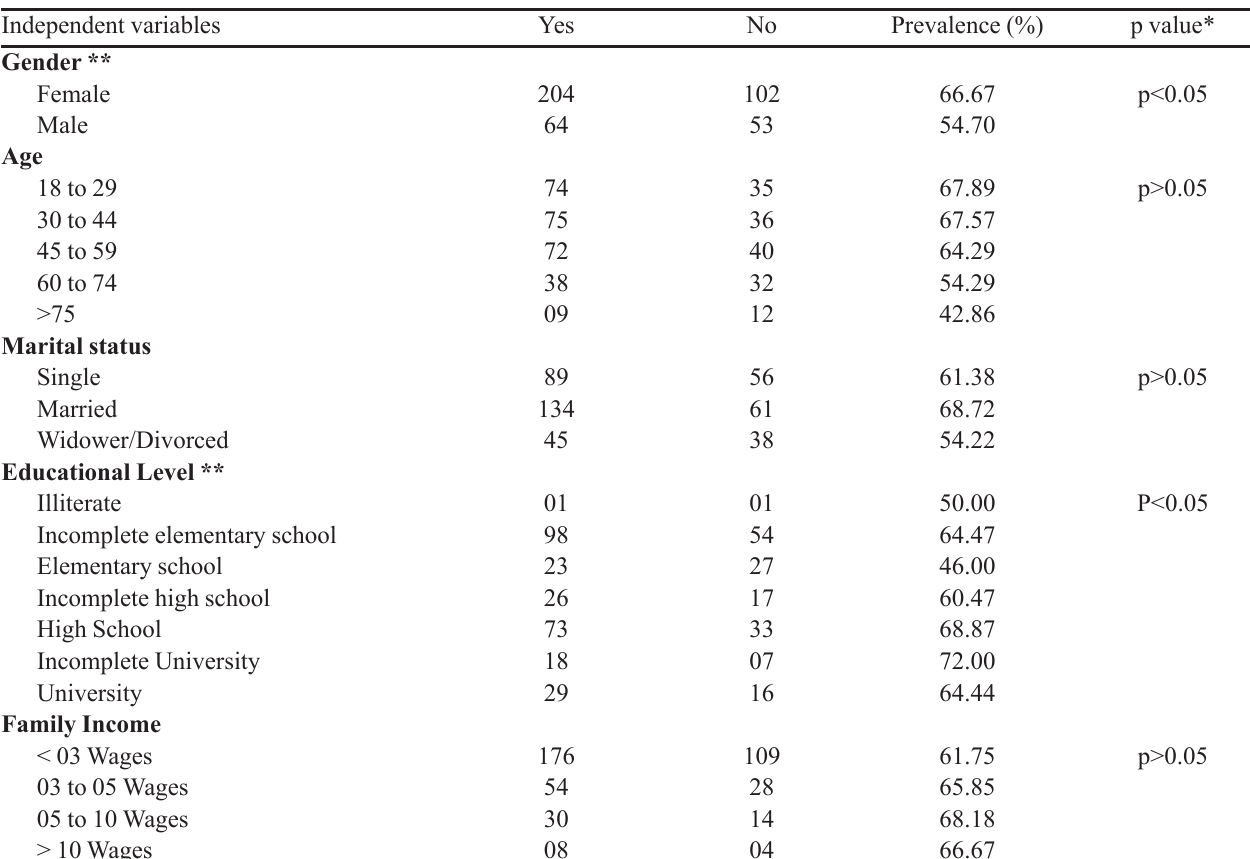
TABLE V - Absolute frequency and prevalence of self-medication by respondents according to demographic and